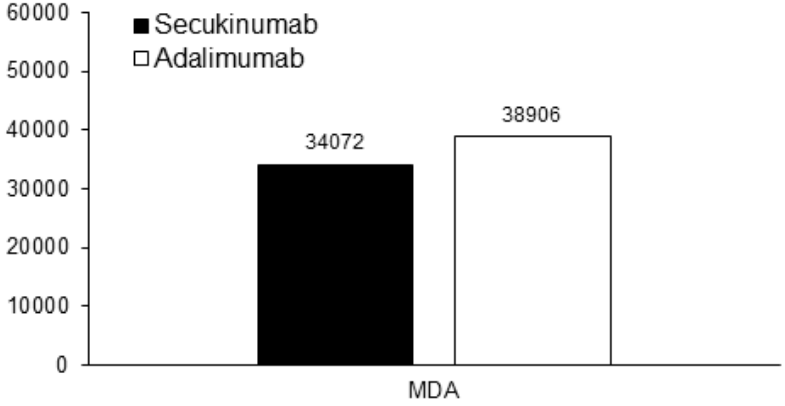
Figure 2. Cost per responder analysis for minimal disease activity in patients receiving secukinumab (black bars) and adalimumab (white bars) at week 52 (in Euro).